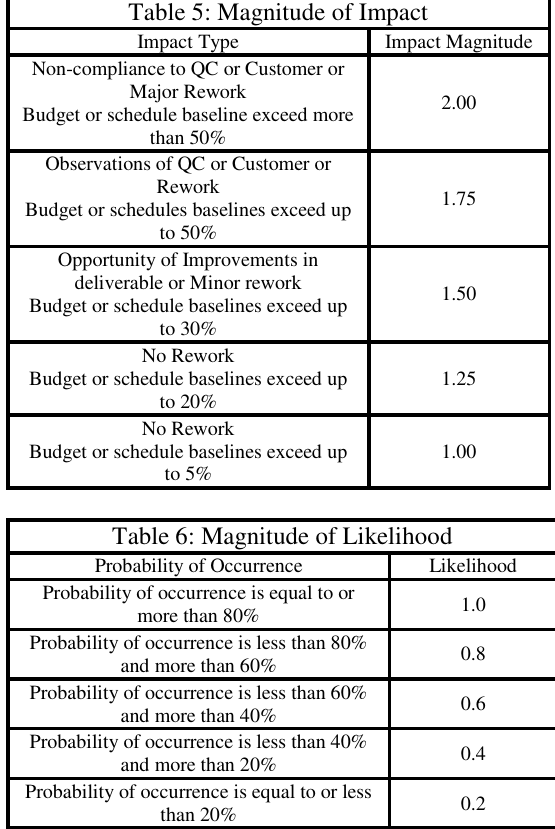
Table 6: Magnitude of